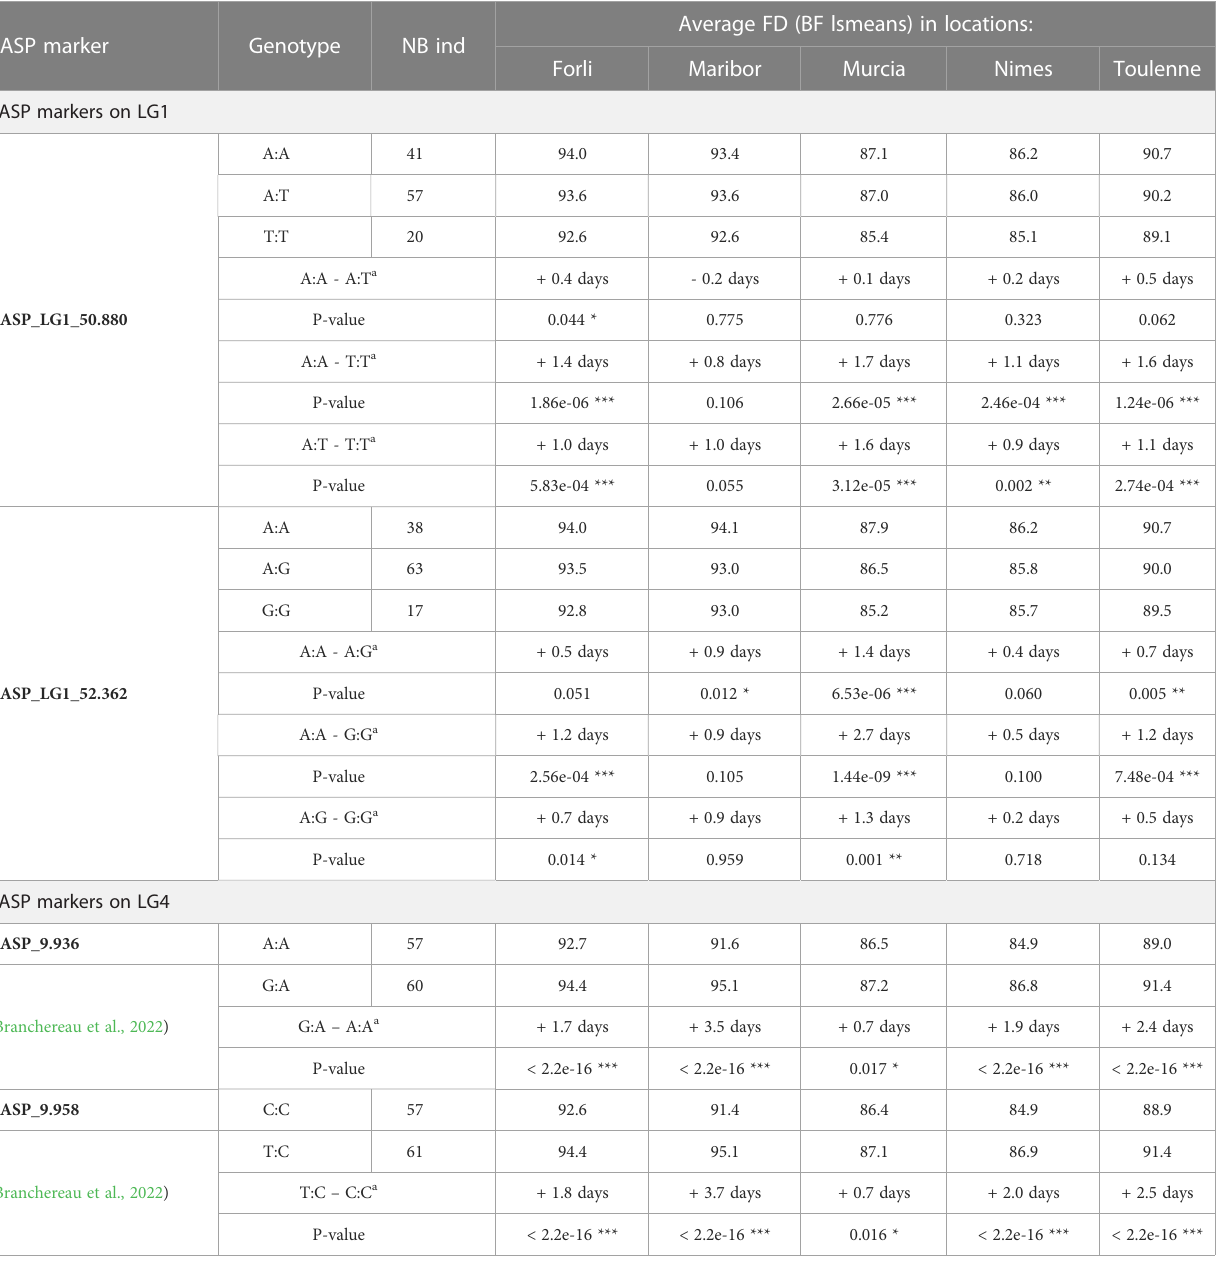
Average FD (BF lsmeans) in locations: Forli Maribor Murcia Nimes Toulenne